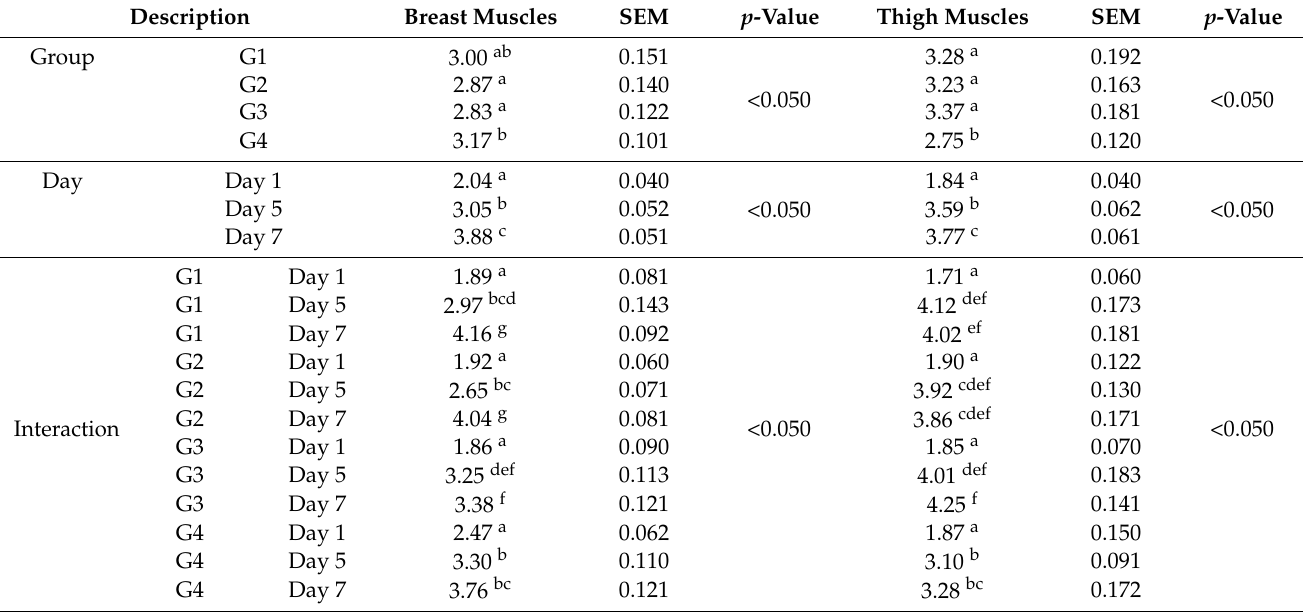
Table 5. Dimalone aldehyde (TBA) content in breast and thigh muscles in fresh chickens and chickens refrigerated for up to seven days ( µ g/g meat).